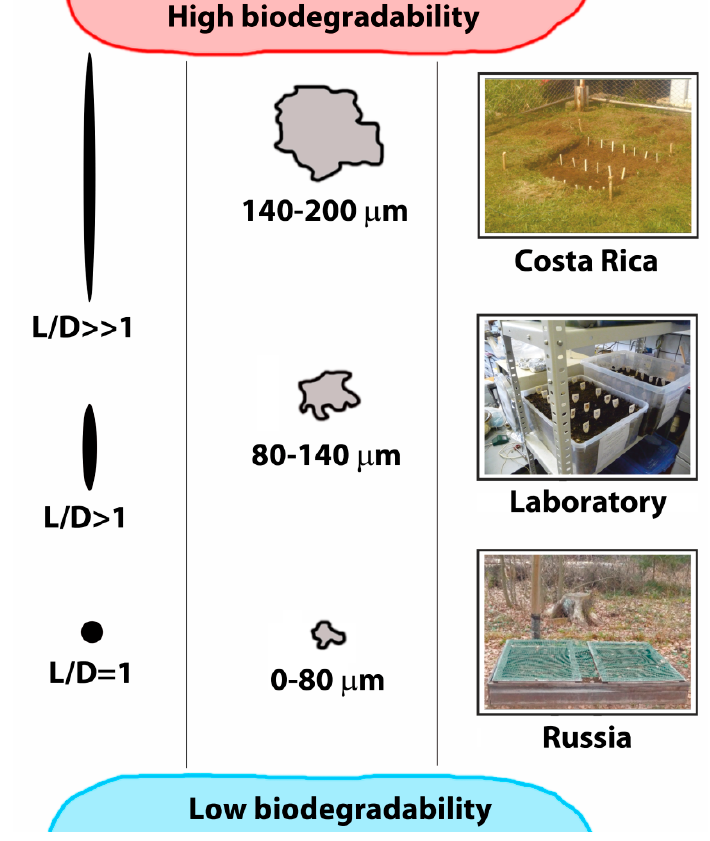
Figure 7. Scheme showing the effect of lignocellulosic filler size on the composite degradation.